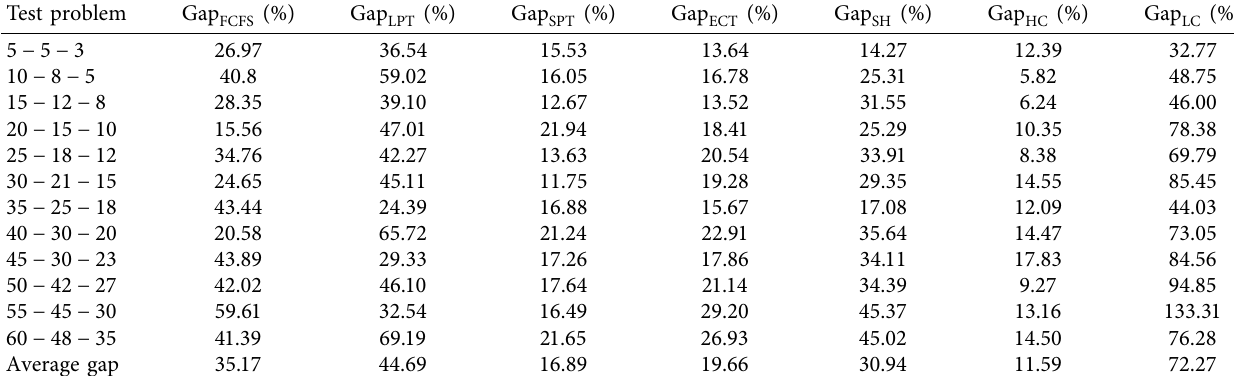
Table 5: Comparison with human-made rules.